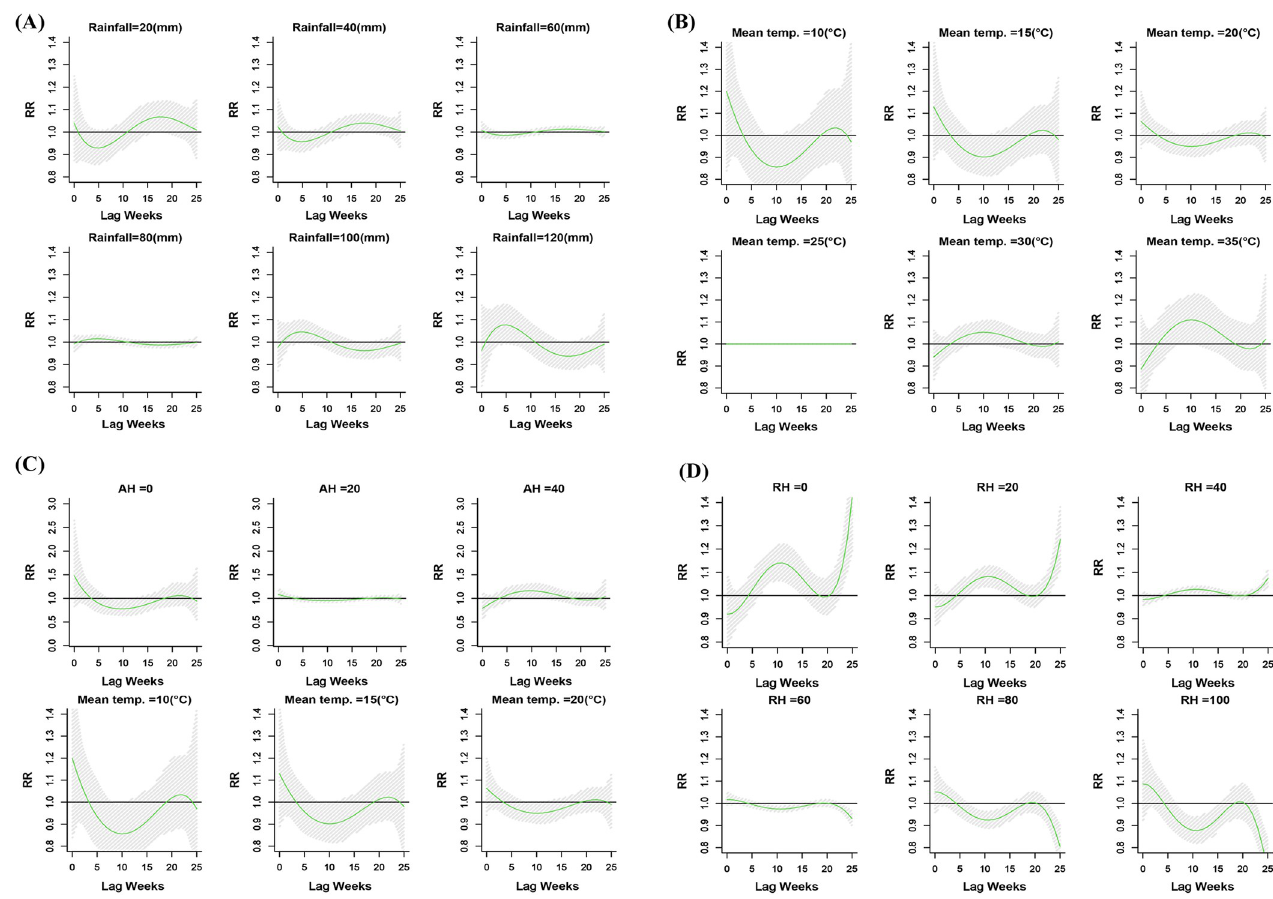
Fig 5. Association of dengue incidence with different ranges of meteorological variables. A) RR by lag weeks at different rainfall (mm) levels. B) RR by lag weeks at different mean temperature (˚C). C) RR by lag weeks at different AH (g/m 3 ). D) RR by lag weeks at different RH (%). The solid green line is the estimated linear curve, with shaded region indicating its 95% confidence